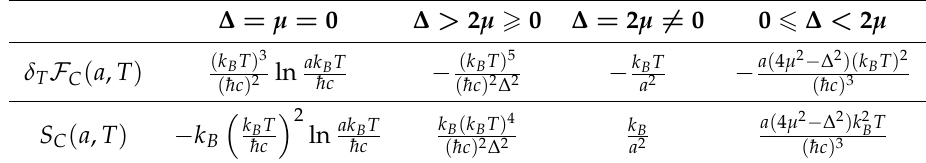
Table 2. Up to an order of magnitude asymptotic behaviors at arbitrarily low temperature of the thermal corrections to the Casimir energy (line 2) and of the Casimir entropy (line 3) under different relationships between the energy gap ∆ and chemical potential µ (line